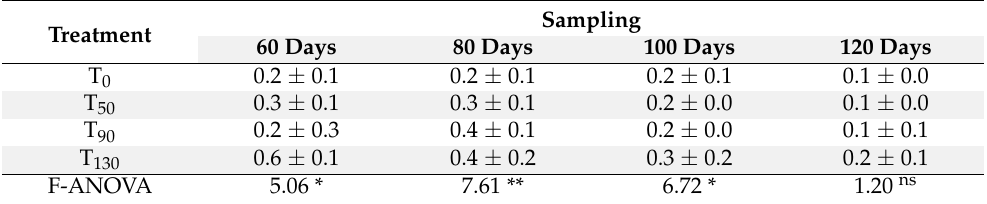
Table 8. Manganese content ( µ g/L) in leachates. Entries represent means ± standard errors from n = 3 replicates.